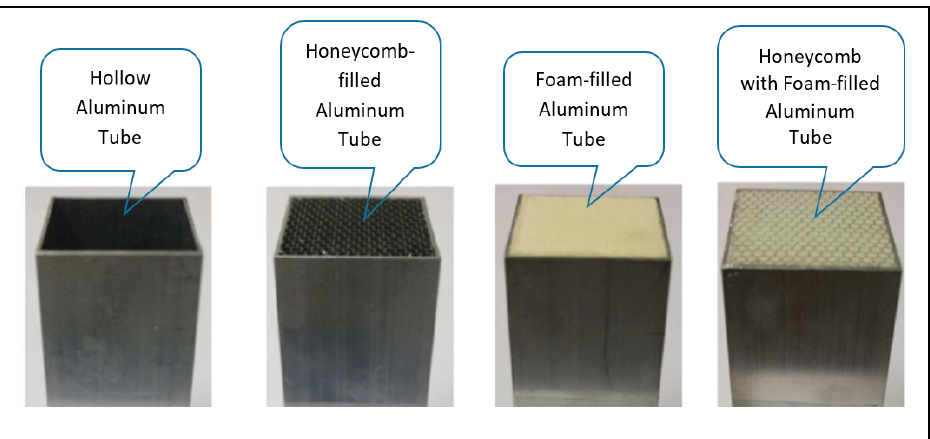
Figure 10. Different innovation of honeycomb filled tube specimens.